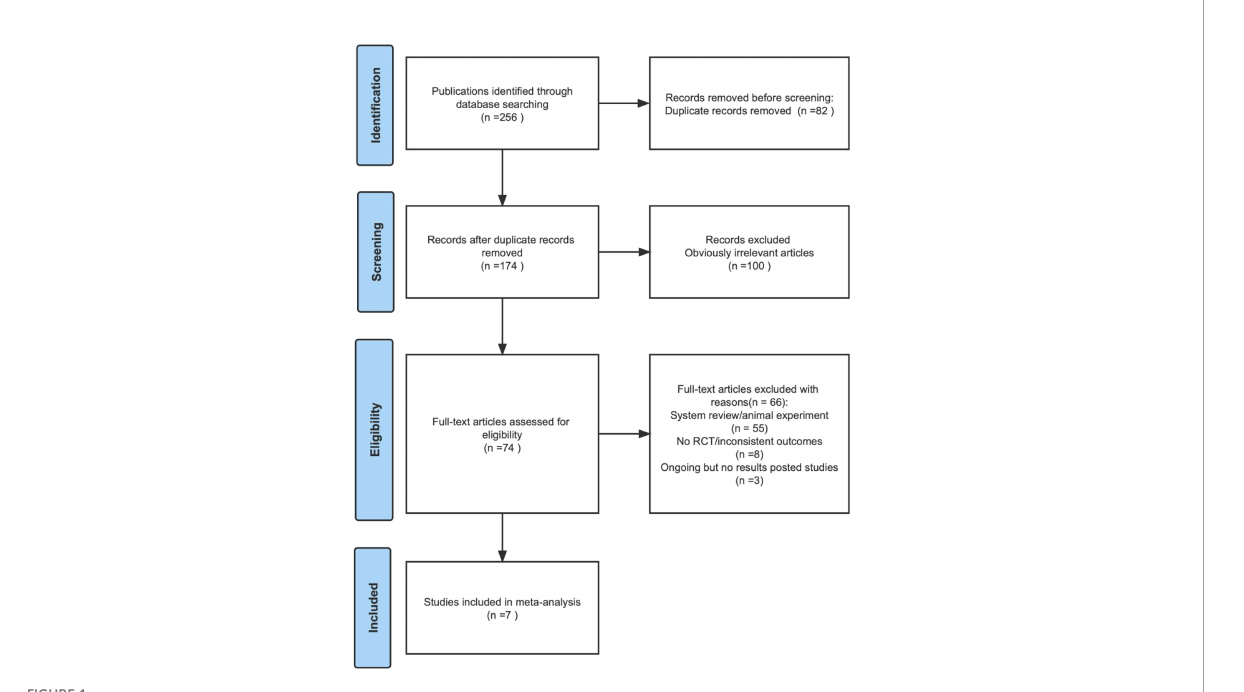
FIGURE 1 Flow diagram of study selection process for the